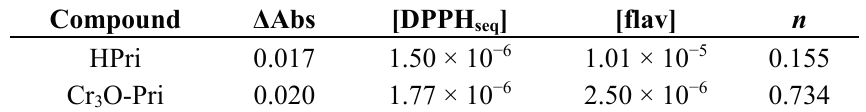
Table 4. Antiradical activities of free and coordinated primuletin based on DPPH